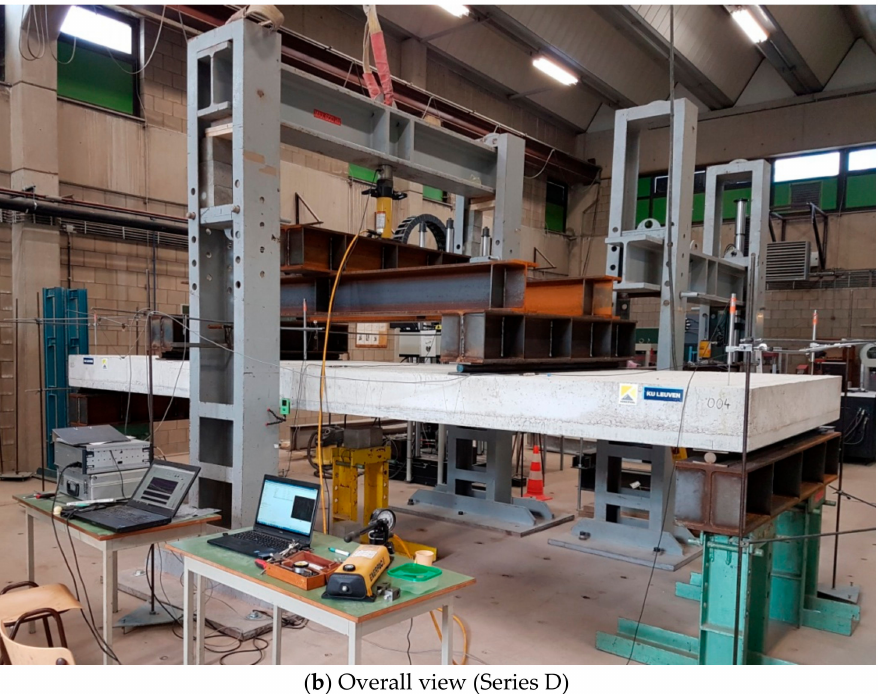
Figure 3. Test setup ( a ) with specifications for each series of tests and ( b ) overall view. Table 3. Dimensions and properties of the test